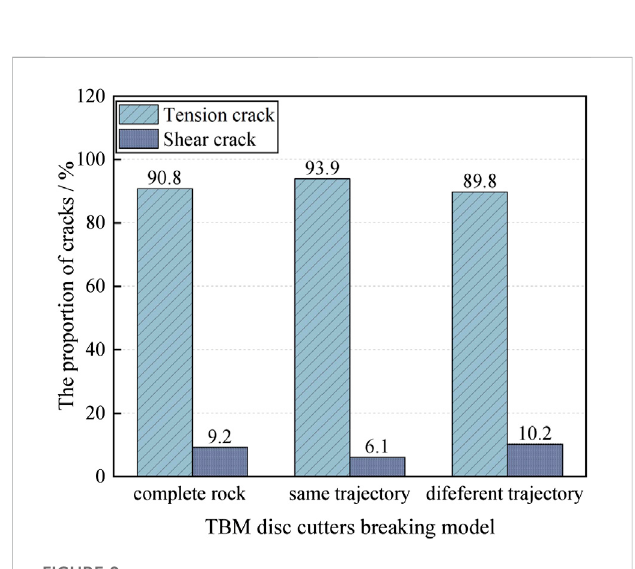
FIGURE 9 Percentage of cracks under different rock breaking